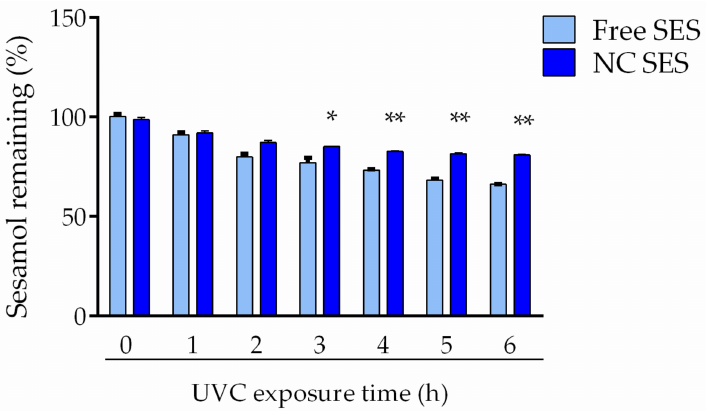
Figure 4. Remaining sesamol content after exposure to UVC radiation. The values are reported as the mean ± SD of three independent experiments. All data were analyzed using the unpaired Student’s t -test at each point (individual time). The asterisks (*) denote a significant difference between the NC SES and Free SES (* p < 0.05; ** p < 0.01).